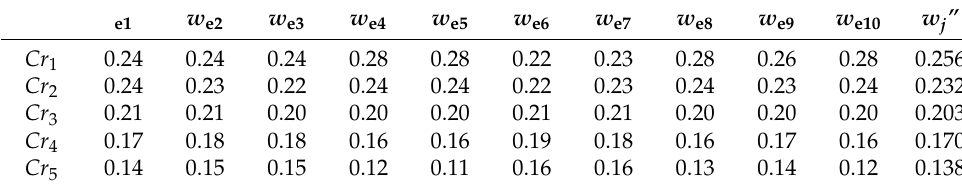
Table 9. Individual and group criteria weights calculated using the PIPRECIA method.